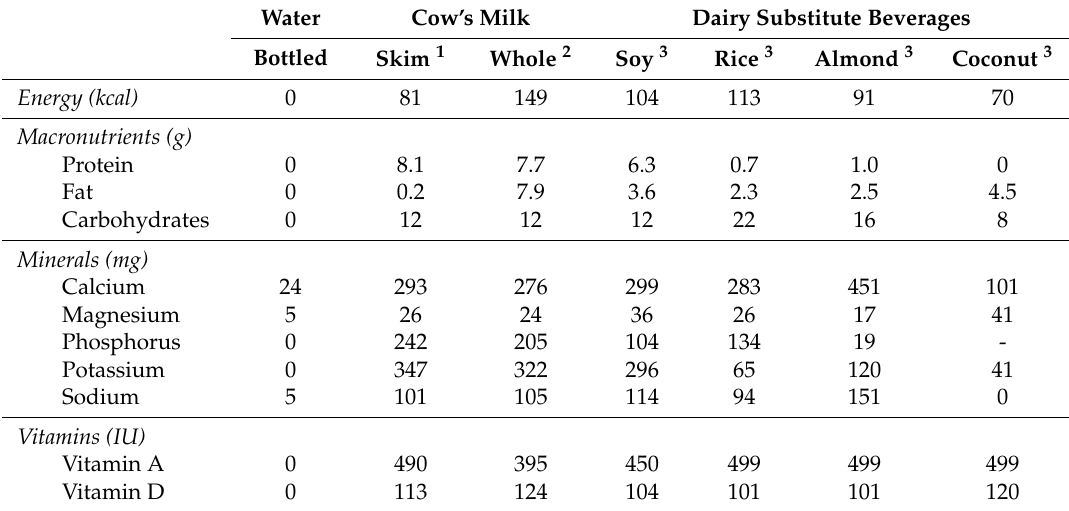
Table 4. Nutrient composition of test beverages